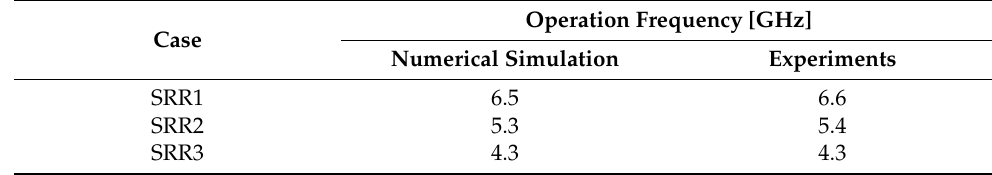
Table 3. Comparison between numerical and experimental data in operation frequency.